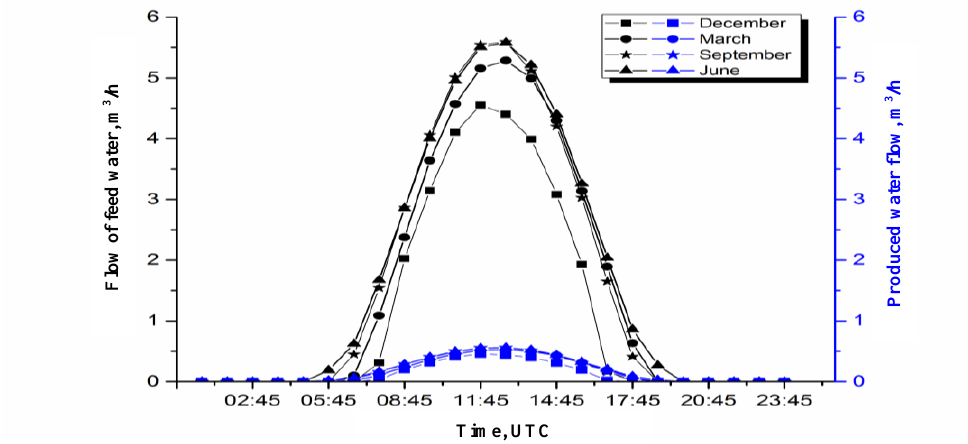
Fig. 7. Flow of feed water and produced water flow for a concentration C a = 10 g/l and a conversion rate y = 10 % in Casablanca. In fact, increase in the feed concentration causes an increase in the osmotic pressure which corresponds to an osmotic counter pressure causing a decrease in the effective pressure. At constant transmembrane pressure, the flux then decreases. On the other hand, increase in the concentration can cause an increase in concentration polarization at the level of the membrane-solution interface as it can accentuate, in a non-systematic way, clogging by gelling or precipitation of solutes.